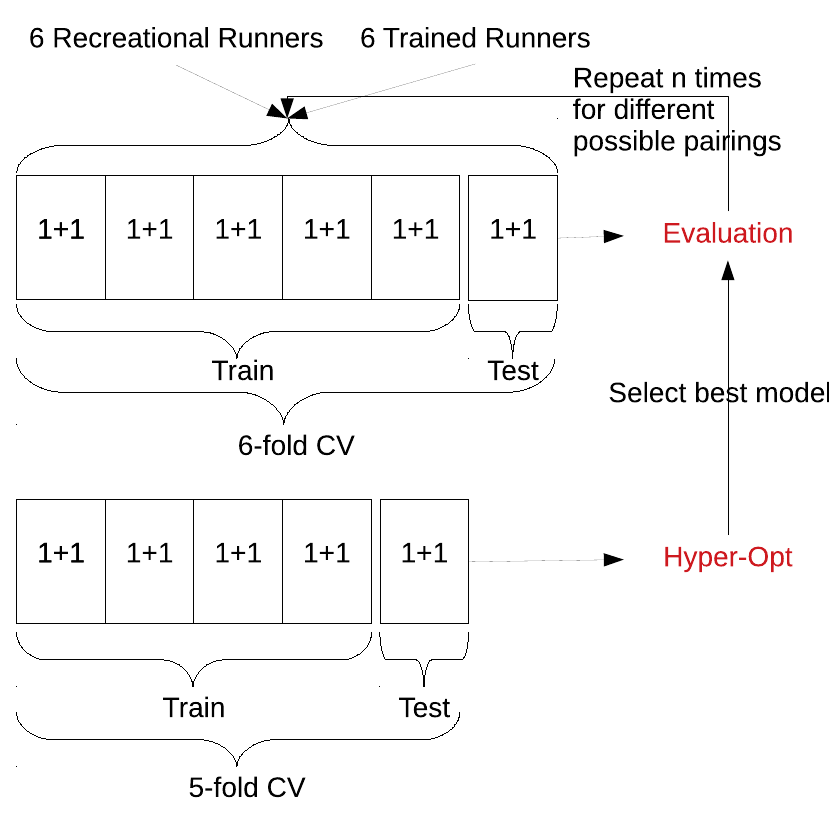
Figure A1. Visual representation of the training and evaluation